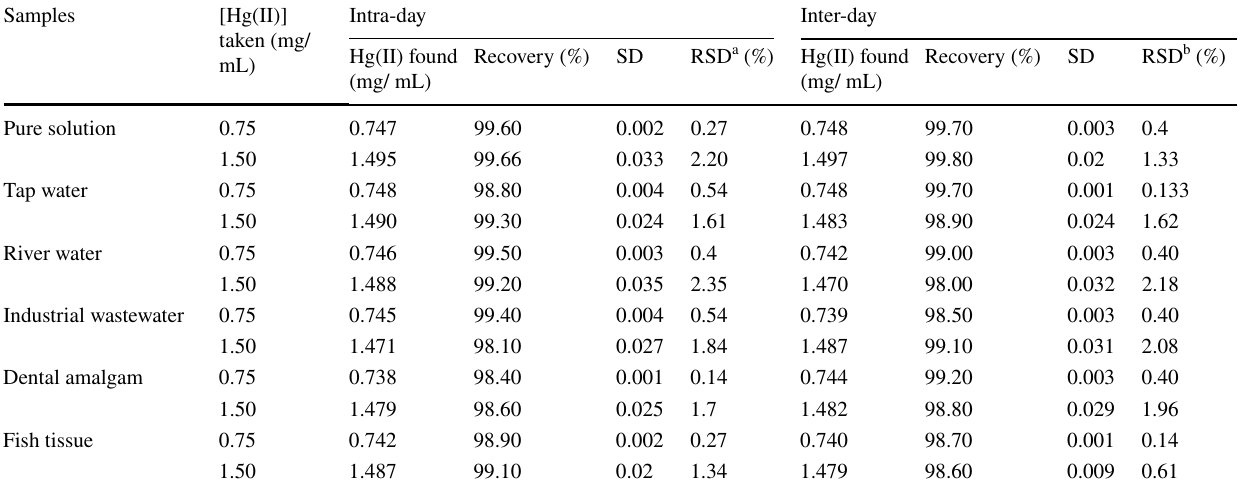
Table 4 Evaluation of intra- and inter-day precision and accuracy of the modified SPE sensor